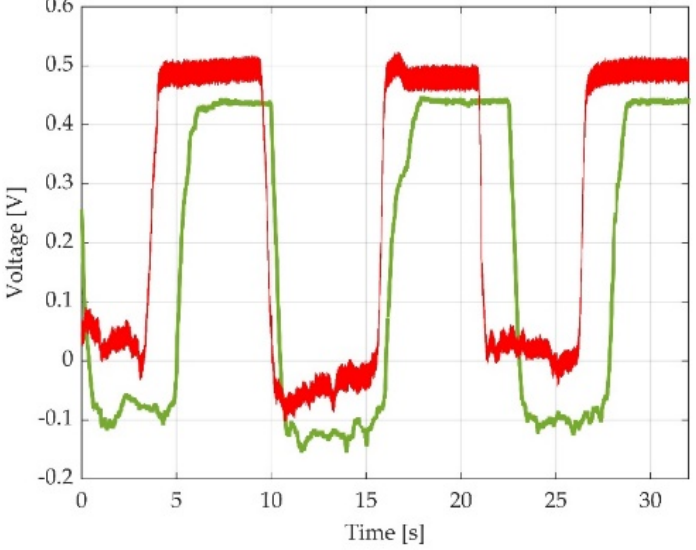
Figure 7. Representation of two overlapped voltage time-graphs selected for one participant during one type of muscle effort. Green line representing dorsiflexion at 0 ◦ of pedal inclination at initial moment; red line representing dorsiflexion at 0 ◦ of pedal inclination at final moment.